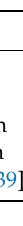
Table 2. Parameters exploited in the